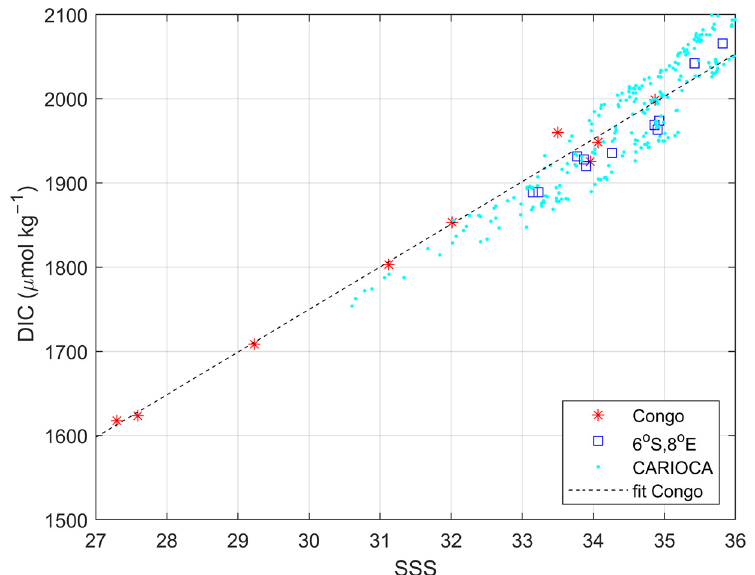
Figure 5. DIC–SSS relationship obtained with the samples near the Congo outflow (dashed line) with DIC samples used for the regression (red stars), DIC samples at 6° S, 8° E (blue squares) and DIC samples used for the regression (red stars), DIC samples at 6 ◦ S, 8 ◦ E (blue squares) and DIC DIC calculated (cyan dots) from daily fCO 2 measured at 6° S, 8° E and TA calculated from SSS at calculated (cyan dots) from daily fCO 2 measured at 6 ◦ S, 8 ◦ E and TA calculated from SSS at 6 ◦ S, 8 ◦ 6° S, 8° E.